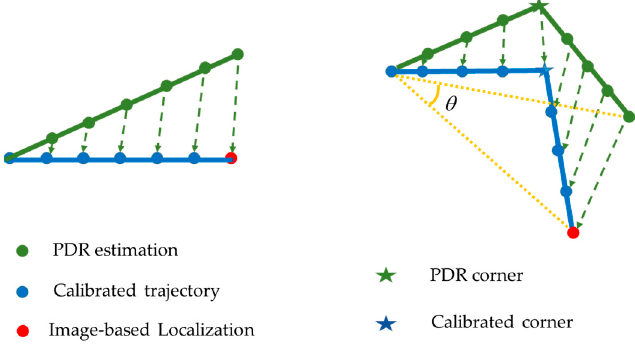
Figure 4. Trajectory back-tracking estimation.